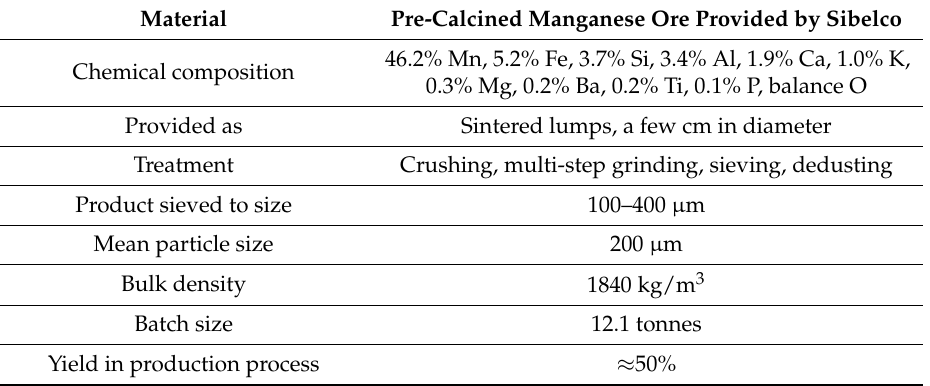
Table 1. Characteristics of the large batch of oxygen